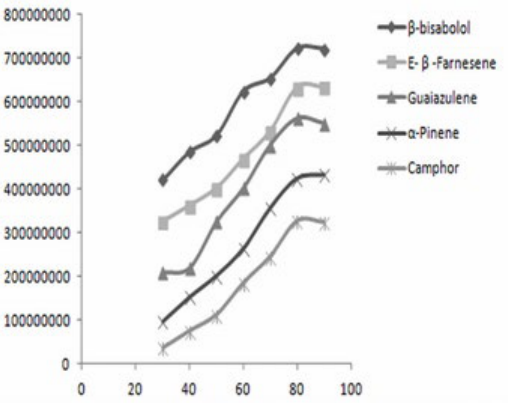
Fig. 1. Effect of extraction temperature on the extraction efficiency. (X= O C, Y=area